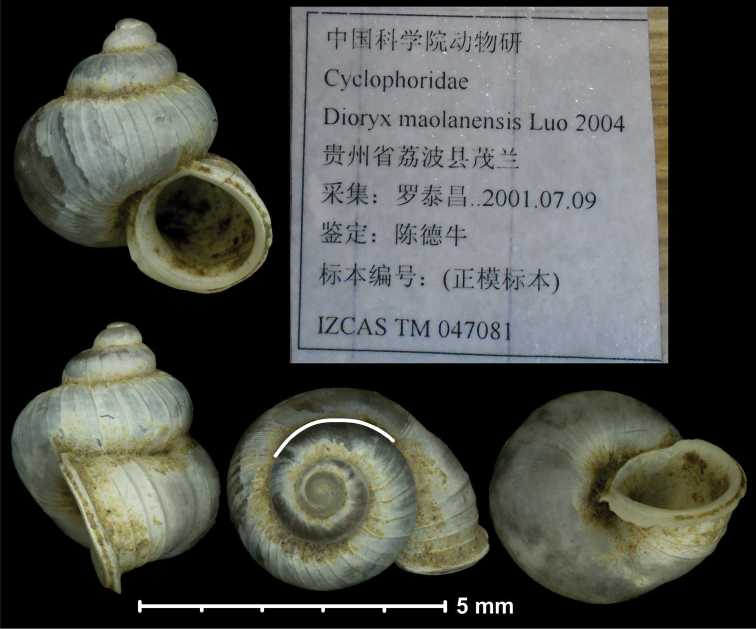
Pincerna
(?)
maolanensis (Luo, Zhang & Zhuo, 2009), holotype (IZCAS TM 047081). White line indicates the length of the sutural tube. Photographs: Kaibaryer Meng.